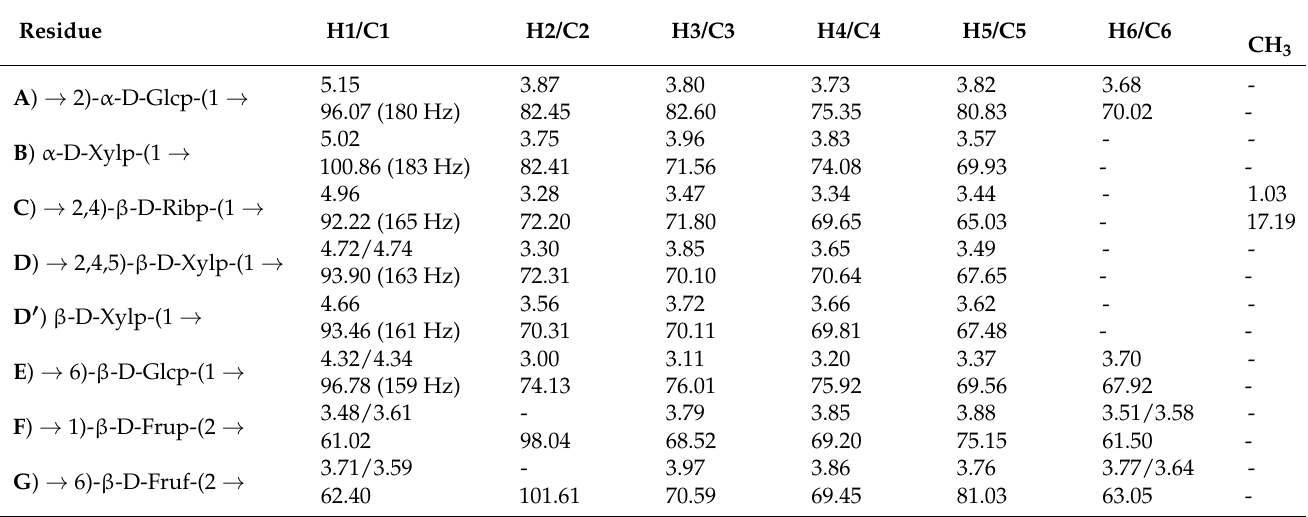
Table 3. 1 H and 13 C NMR chemical shifts ( δ , ppm) of EPS.